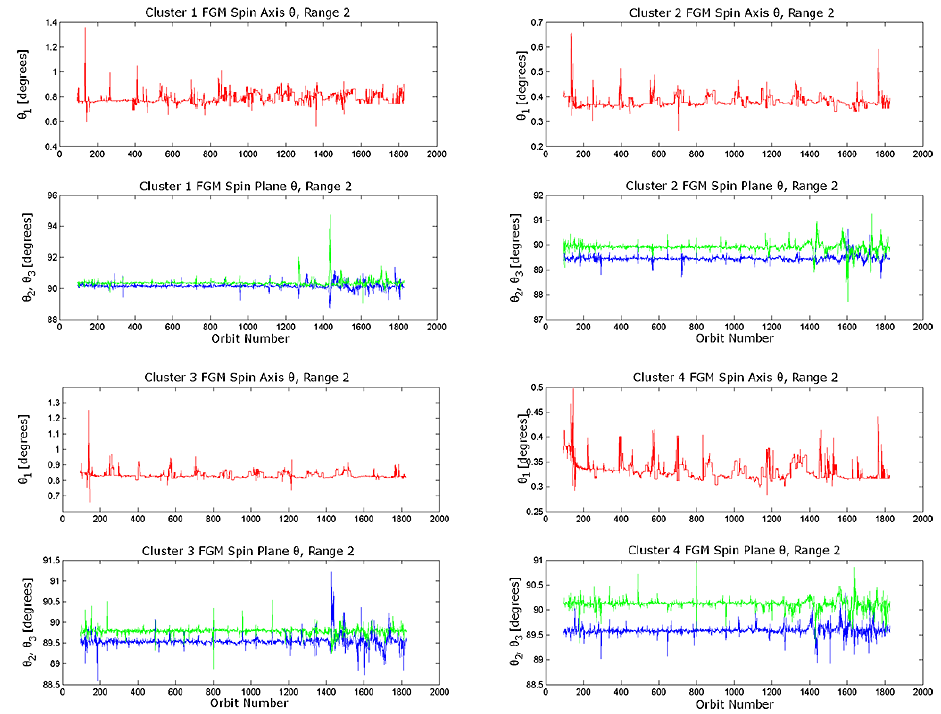
Figure 12. Elevation angle, θ i , plots from February 2001 to February 2012 for range 2 for all